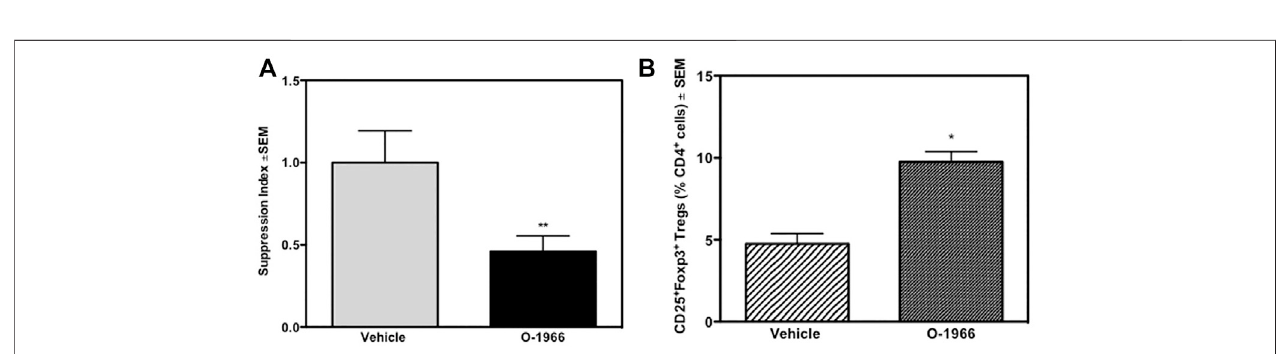
FIGURE5| Invivo O-1966treatmentdecreasesproliferationandincreasesthepercentage ofTregsfollowing exvivo stimulation.DonorC3HeB/FeJ fl ankskinwas transplanted to the back of recipient C57BL/6J mice, sutured, and bandaged. Doses of O-1966 (5 mg/kg) or vehicle (0.03% ethanol and 0.03% cremophor in saline) were injected i.p. every other day from 1 h pre-op to 14 days post-op. On post-op day 14, animals were sacri fi ced and spleens were aseptically removed, restimulated withC3HeB/FeJsplenocytesandputintocultureforMLR (A) orharvestedat48 handanalyzedby fl owcytometry (B) . (A) Proliferationofcultureswithsplenocytes from O-1966 treated mice ( ) or vehicle treated mice ( ) . (B) Cultures harvested at 48 h from mice treated with O-1966 ( ) or vehicle ( ) and analyzed by fl ow cytometry for CD25 + Foxp3 + Tregs (n (cid:1) 17 for both groups). Data show number of Tregs as a percentage of total live CD4 + cells (LIVE/DEAD ® dead cell stain negative). Data are mean of two separate experiments. * p < 0.05, ** p < 0.01 for O-1966 vs. vehicle by one-way ANOVA followed by Tukey ’ s multiple comparison